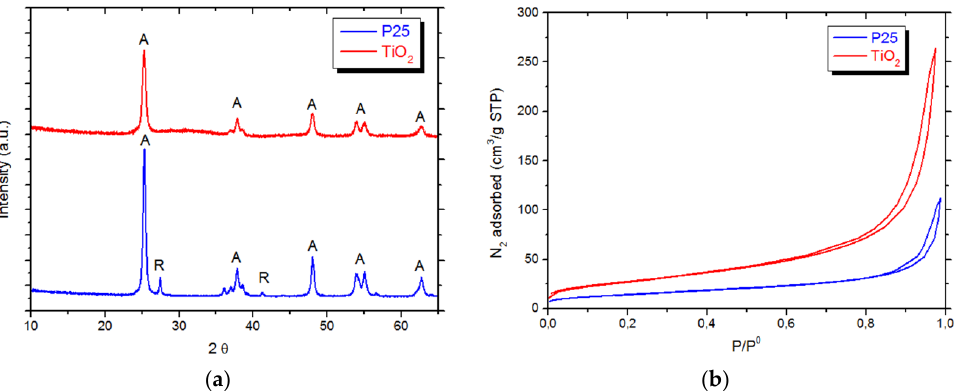
Figure 2. ( a ) XRD spectra of TiO 2 and P25. Anatase peak are labelled with A and rutile peak with R; ( b ) Nitrogen physisorption isotherms of TiO 2 and P25.